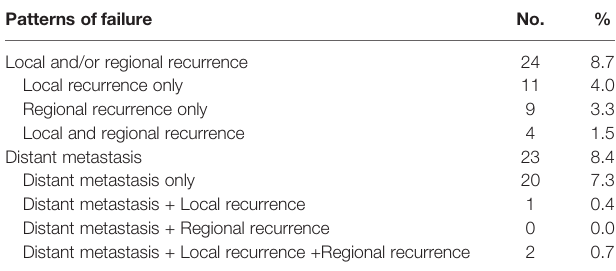
TABLE 1 | Characteristics of the 275 patients with stage N1 nasopharyngeal carcinoma treated by contralateral lower neck sparing radiotherapy. Characteristic No.